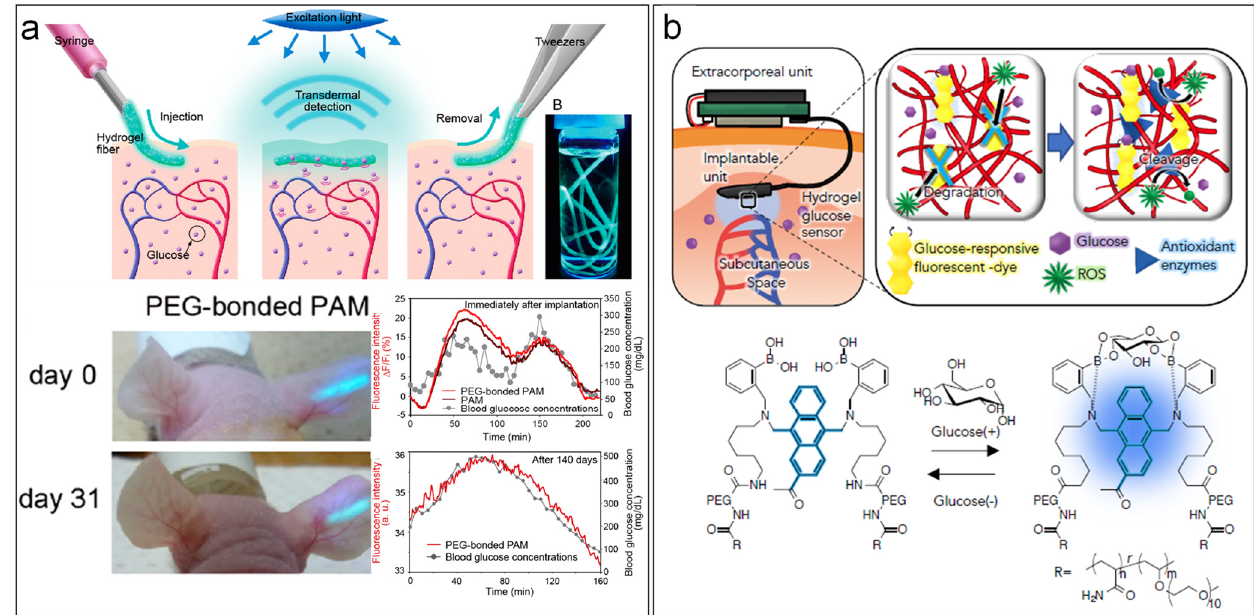
Figure 2. Implantable devices for blood-glucose monitoring. ( a ) Hydrogel-modified fibre with fluorescence responsivity operating in the ears of mice and responding to blood-glucose levels. Adapted with permission from Yun Jung Heo et al. [73], ( b ) Subcutaneous device with boronic acid-based glucose responsive fluorescent dye protected within a hydrogel doped by antioxidant enzymes. Adapted with permission from Sawayama et al.